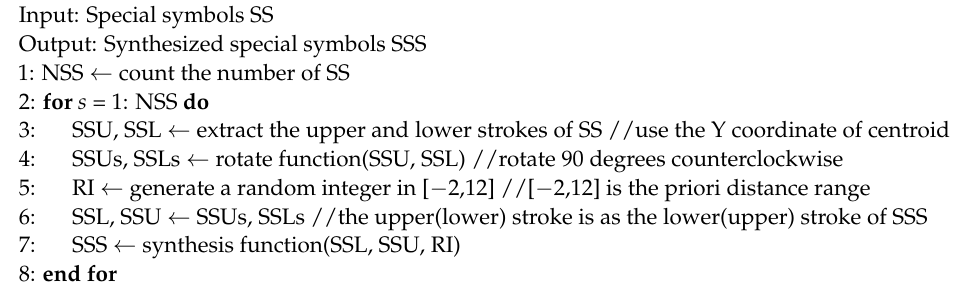
Algorithm 3: Special character synthesis algorithm based on the random distance between upper and lower strokes Input: Special symbols SS